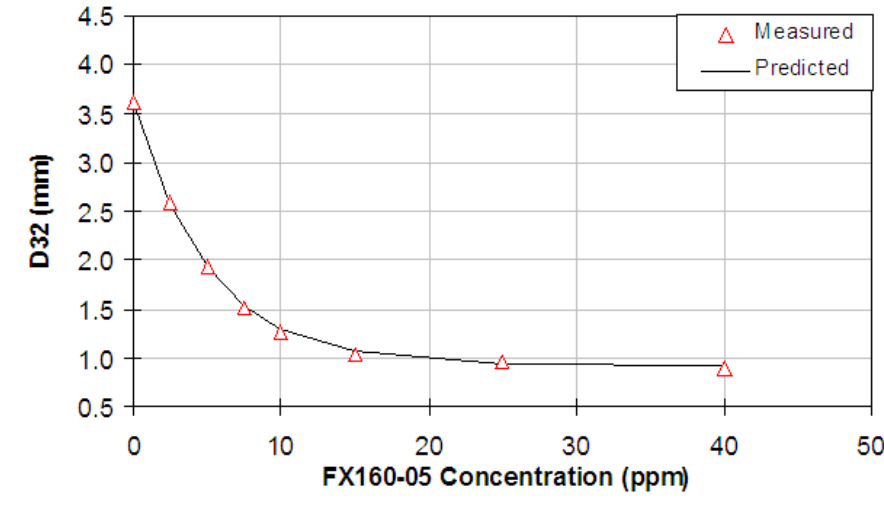
versus FX160-05 frother 32